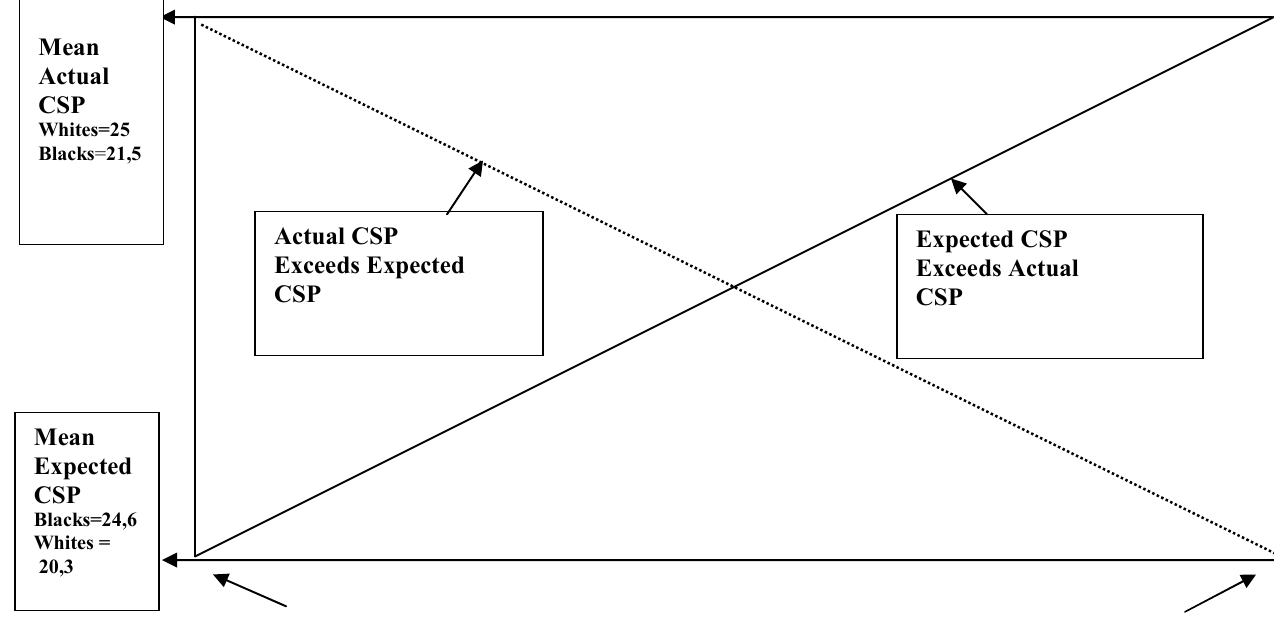
Figure 2: High-low mean